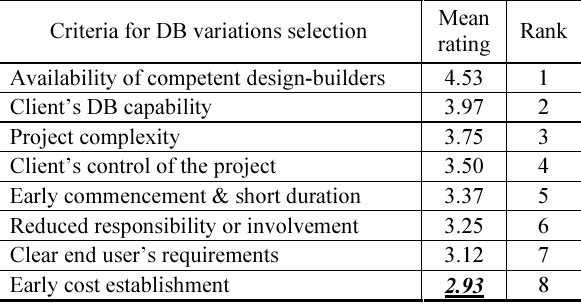
Table 7. The results of round 3 of the Delphi survey Criteria for DB variations selection